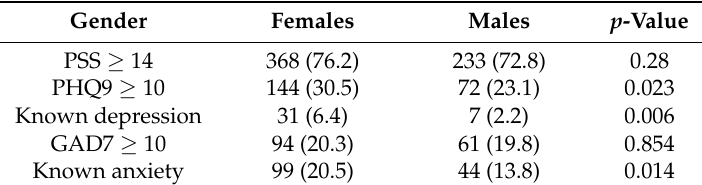
Figure 2. Psychiatric illness prevalence rates for the three self-reported psychiatric scales: ( A ) prevalence rates by age group; ( B ) prevalence rates by gender and age group. Note: * p < 0.05, † p < 0.01. Table 3. Association between gender and psychiatric illness 1 .